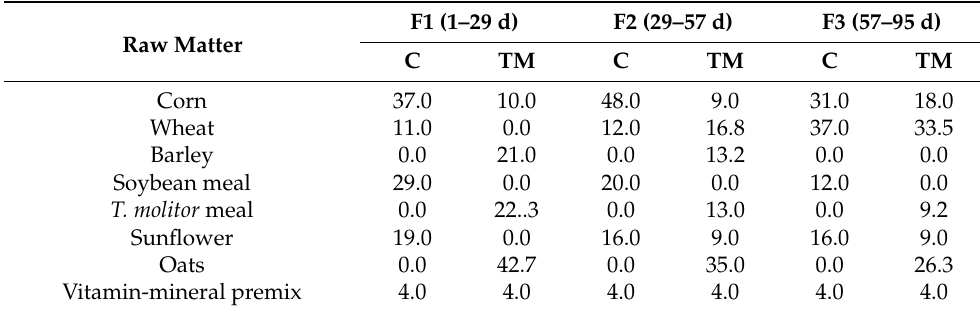
Table 1. Compositions of the experimental diets for the two studied groups of chickens expressed as percentages of raw